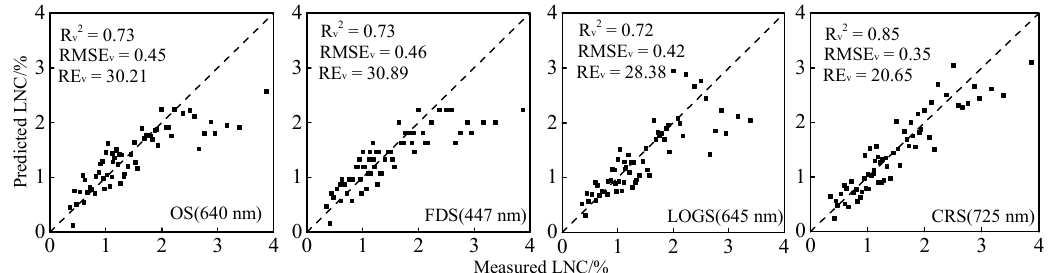
Figure 4. Scatter plots between the measured and predicted leaf nitrogen concentration based on